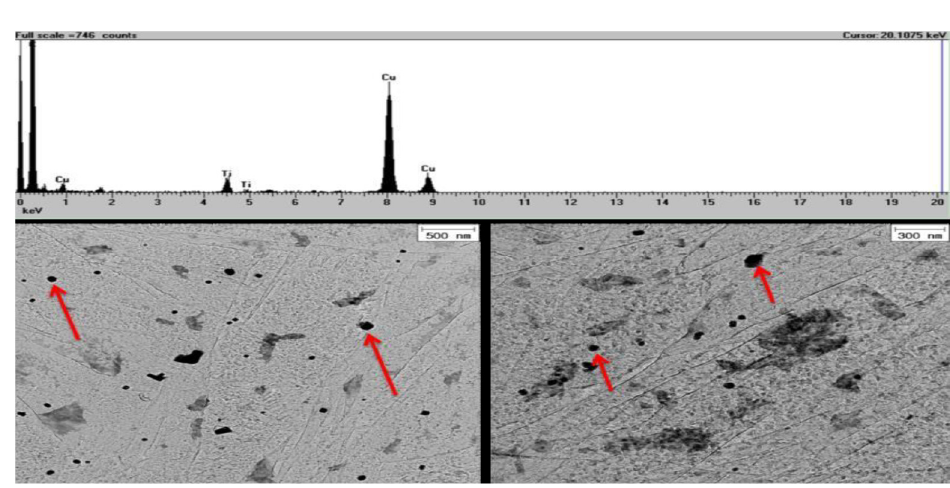
Fig. 8: TEM Micrographics with EDS for sample B